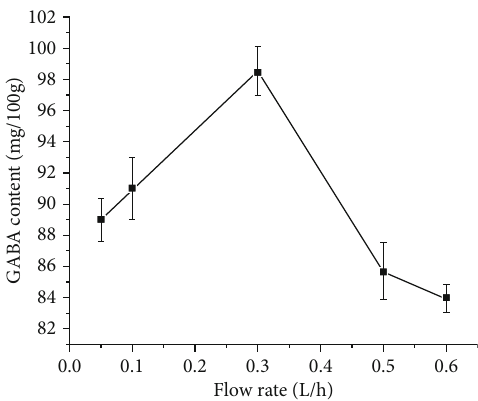
Figure 12: E ff ect of pressure on the GABA content.